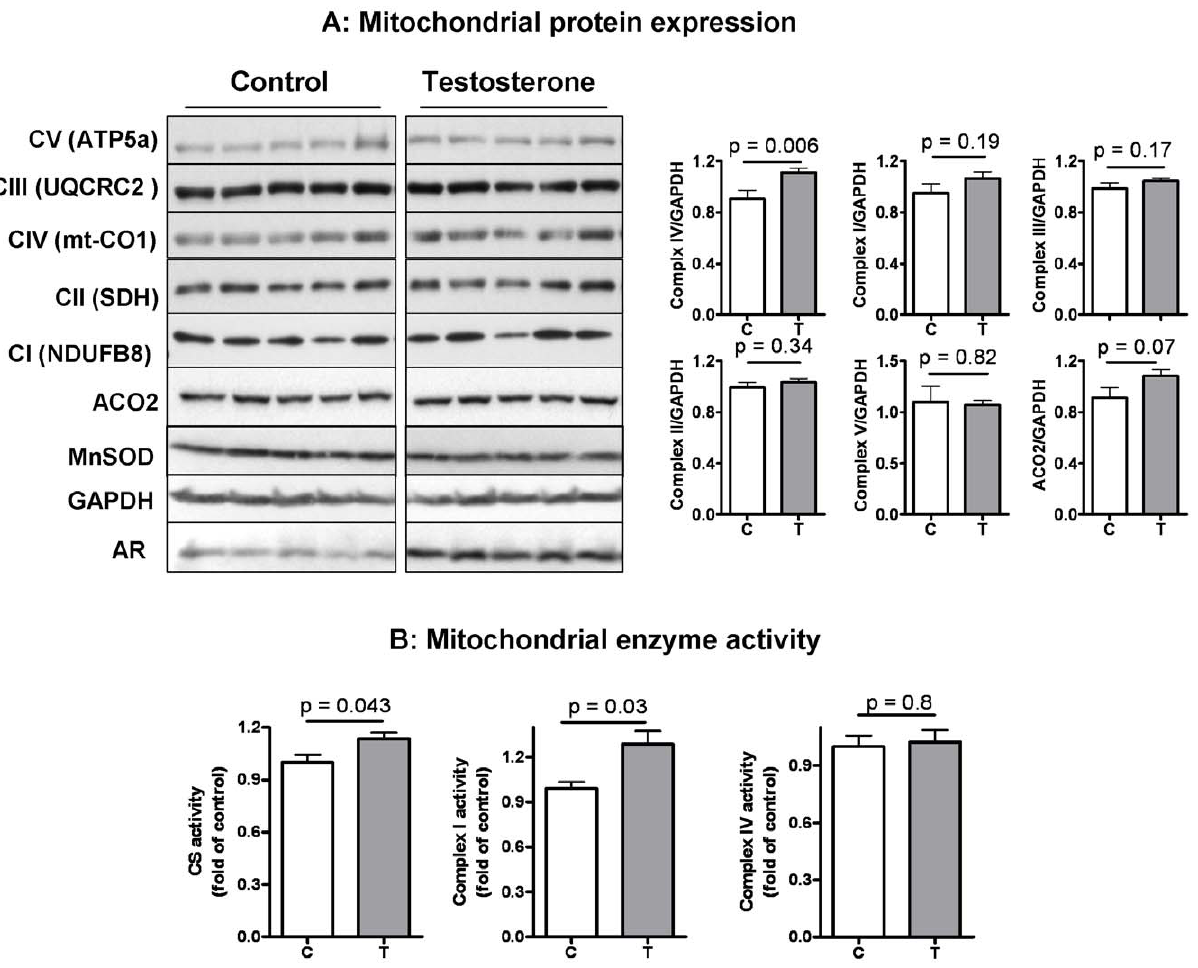
Figure 3. Effect of testosterone supplementation plus low-intensity physical training on the expression of mitochondrial proteins and the activity of mitochondrial marker enzymes in skeletal muscle. ( A ) (left panel) Western analysis of a panel of subunits of complex I-V as well as mitochondrial aconitase (ACO2) and superoxide dismutase (MnSOD). GAPDH was used as loading control and expression of androgen receptor was measured as a positive control; (right panel) quantification of protein expression normalized to GAPDH. ( B ). Activity of mitochondrial enzyme citrate synthase, complex I, and complex IV. All measurements were performed using whole tissue homogenates of the triceps muscle group. Bar graphs are presented as mean 6 SEM and group means were compared using Student’s t test, N=5 for the control (C) group and 8 for the testosterone (T) group.